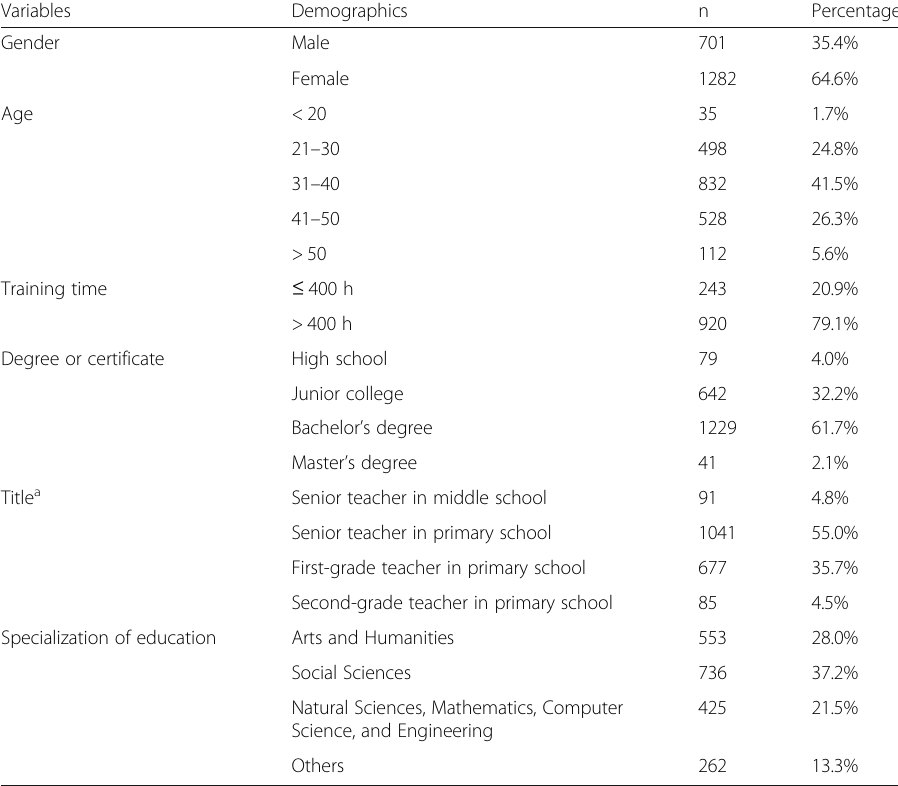
Table 1 Basic information about the participants